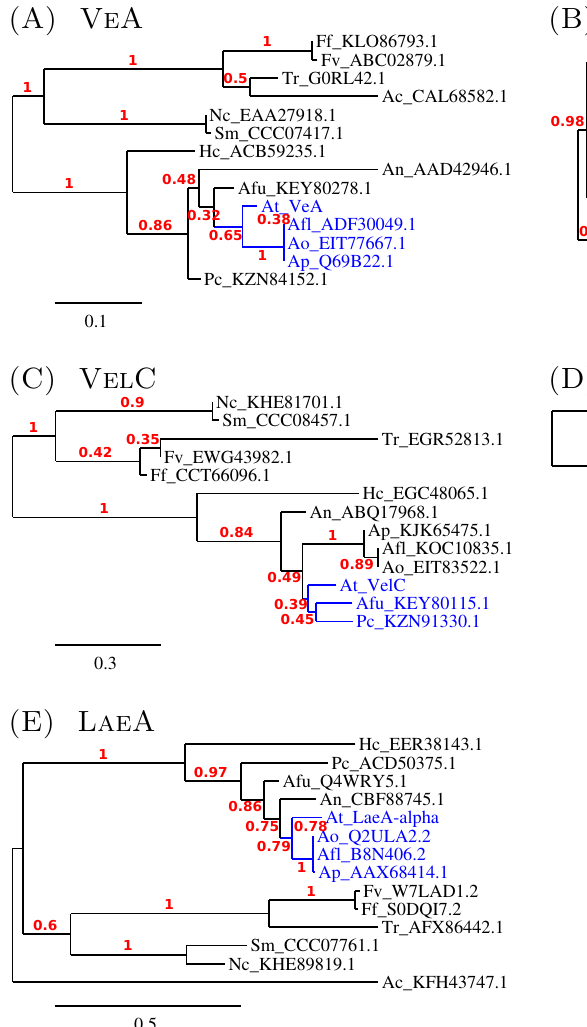
Figure 3. Phylogeny of velvet family members of several Ascomycota fungi. The separate phylogenetic trees consist of velvet proteins similar to ( A ) VeA, ( B ) VelB, ( C ) VelC, ( D ) VosA and ( E ) LaeA of A. nidulans . The protein sequences of the velvet members were obtained, aligned and phylogenetically grouped as described in the Methods. The scale bars represent the residue change per site, and the numbers indicate the probability of the suggested differentiation. No outgroup was used except for the LaeA phylogram. The organisms used in the phylograms: Ac, Acremonium chrysogenum ; Afl, Aspergillus flavus ; Afu, Aspergillus fumigatus ; An, Aspergillus nidulans ; Ao, Aspergillus oryzae ; Ap, Aspergillus parasiticus ; At, Aspergillus terreus ; Ff; Fusarium fujikuroi ; Fv, Fusarium verticillioides ; Hc, Histoplasma capsulatum ; Nc, Neurospora crassa ; Pc, Penicillium chrysogenum ; Sm, Sordaria macrospora ; Tr, Trichoderma reesei . The protein sequences (except for At_VeA, At_VelB, At_VelC, At_VosA and At_LaeA) were obtained from the following databases: GenBank, EMBL, UniProtKB and NCBI RefSeq. The transcript structure of the velB ortholog appears to indicate a slightly longer ORF than annotated for the NIH2624 strain, encoding an earlier start code leading to a 12 bp longer ORF (Tables 2 and S3). Otherwise, the exon locations are the same as annotated for the strain NIH2624. The velB transcript has an upstream intron, which displays putative minor alternative splicing on remains unchanged. Approximately 88% of the covering reads with 110 splice junctions indicate